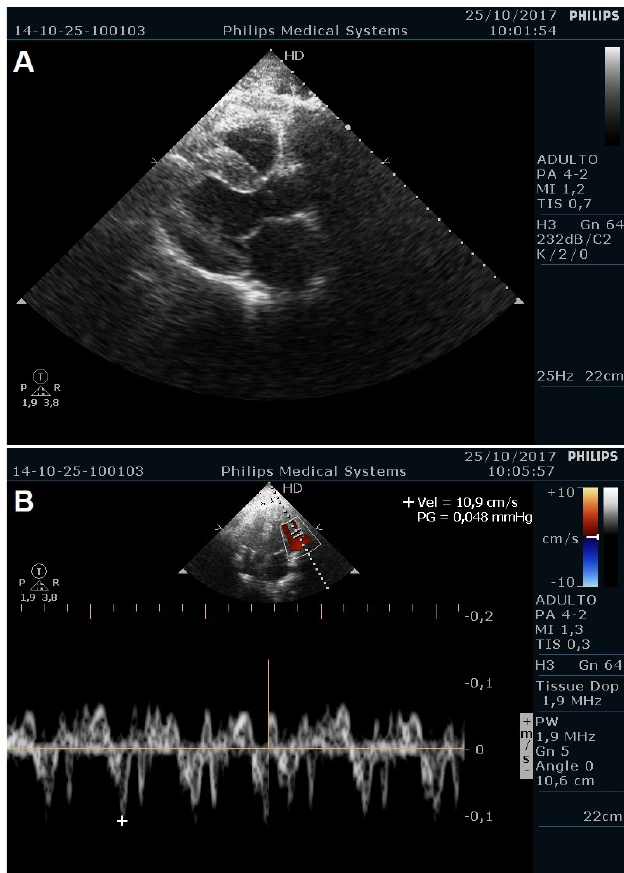
Figure 1. Echocardiographic imaging of case (powerlifter). Panel A: two-dimensional imaging using a parasternal longitudinal view. Panel B: four-chamber view on tissue Doppler for assessment of left ventricle diastolic function.